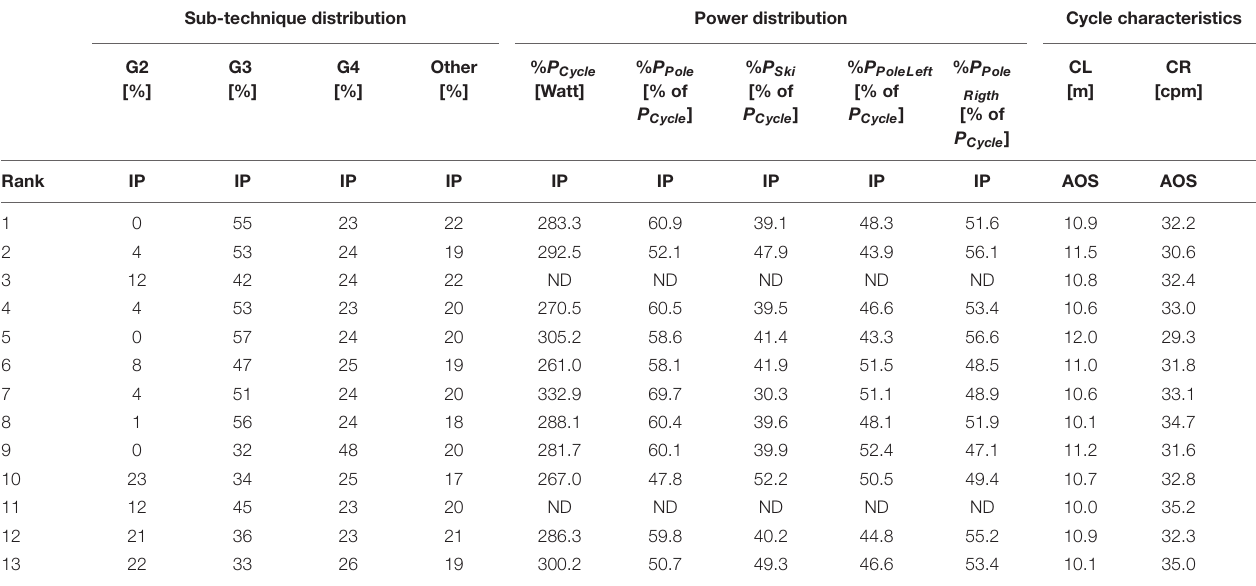
TABLE 3 | Distribution of sub-technique, power and cycle characteristics (mean values) measured during the initial part (IP; lap 1 to lap 3) of the simulated mass-start or during the first three steps of the all-out sprint (AOS). Sub-technique distribution Power